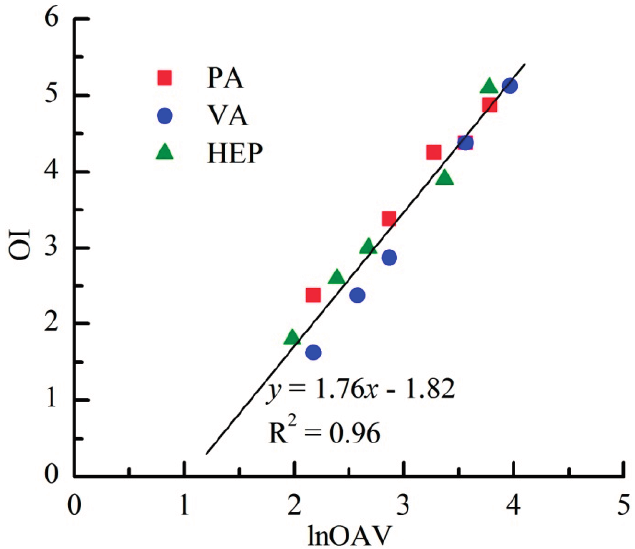
Figure 3. Odor intensity as a function of the concentration of the individual